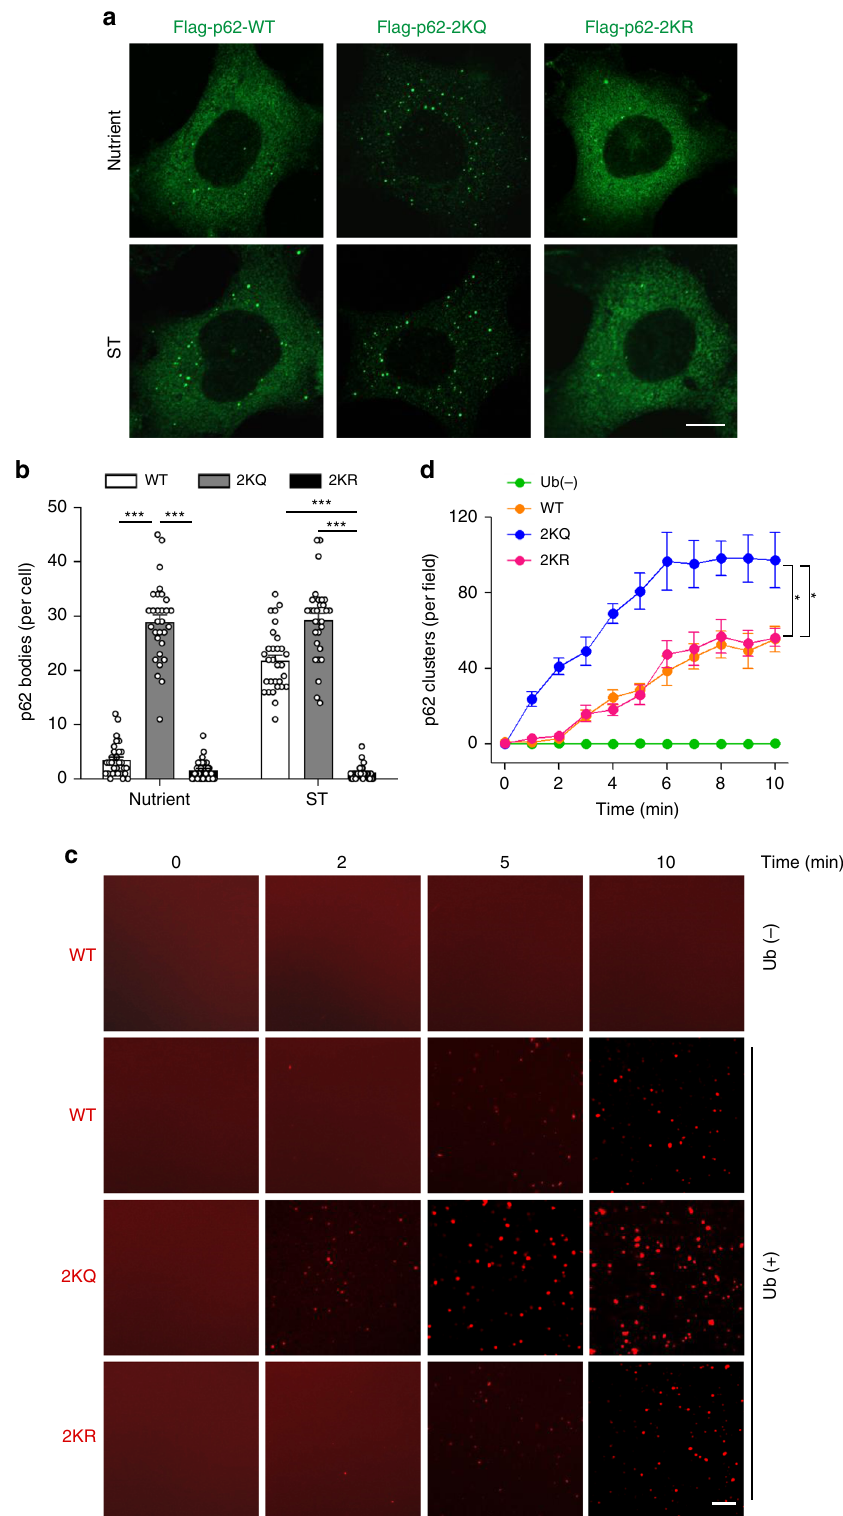
Fig. 7 Acetylation enhances p62 body formation. a Acetylation of p62 affects the formation of p62 bodies. p62 -KO HEK293 cells stably expressing Flag- tagged WT p62, p62-2KQ or p62-2KR were treated with or without starvation, then the cells were stained with anti-Flag and imaged by confocal microscopy. Scale bars, 5 µ m. b Quanti fi cation of p62 puncta in ( a ). The data are presented as mean ± S.E.M., n = 30 cells. Two-tailed t test, *** p < 0.001. c In vitro phase separation of p62. Puri fi ed recombinant mCherry-tagged WT p62 or each of the indicated p62 mutant proteins was incubated with linear 8 × ubiquitin and visualized by confocal microscopy at different time points. mCherry-p62, 5 μ M; linear 8 × ubiquitin, 1.5 μ M. Scale bars, 5 µ m. d Quanti fi cation of the number of mCherry-p62 clusters in c . The data are presented as mean ± S.E.M., n = 5 fi elds. Two-tailed t -test, * p < 0.05. Source data are provided as a Source Data fi